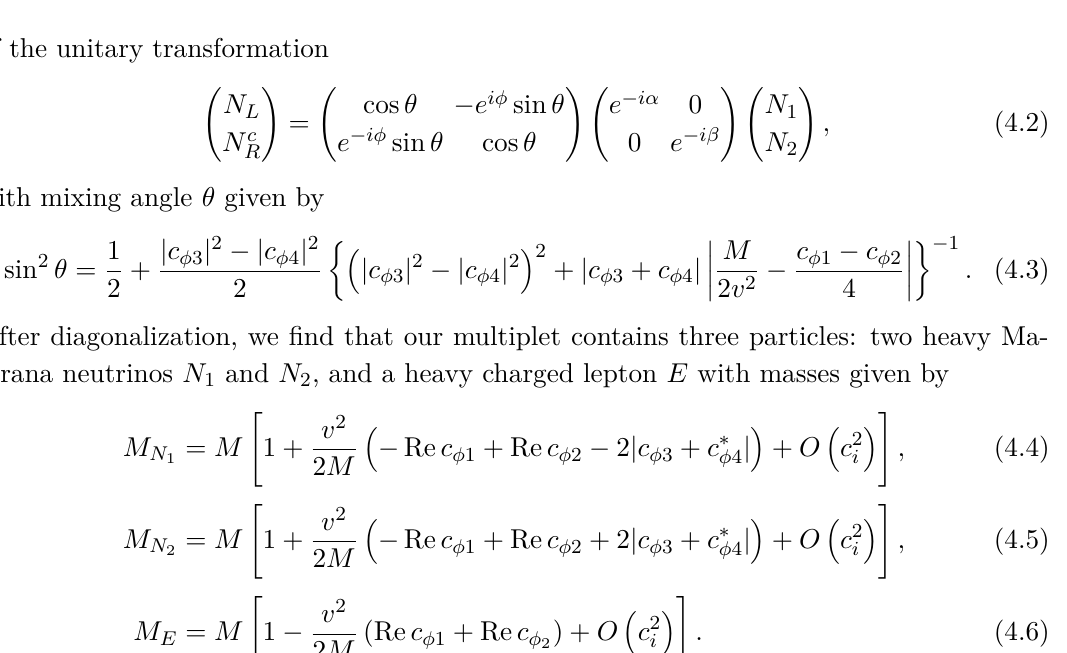
Table 3 . Dimension-5 operators for a DM lepton doublet. All of them contribute to the DM annihilation cross